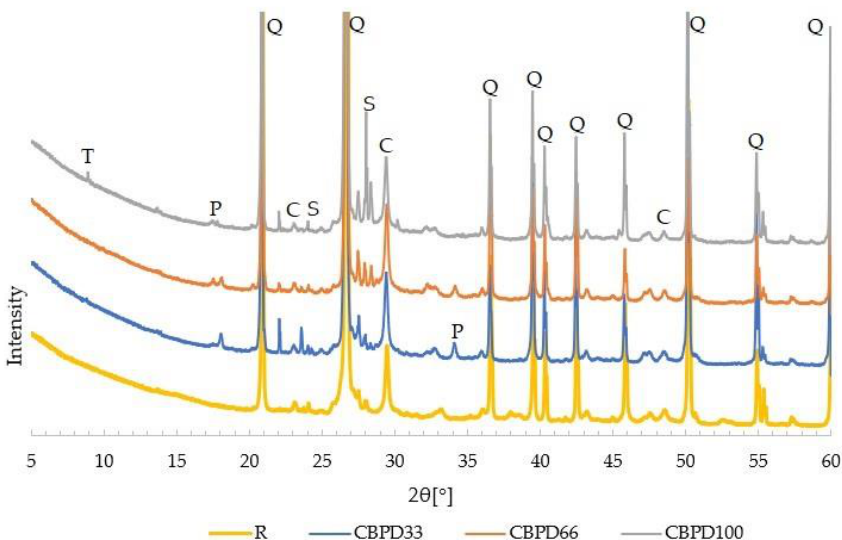
Figure 7. Diffraction pattern of autoclaved sand – lime products with 33%, 66% and 100% CBPD in in relation to free CaO, compared to a reference sample. Designations: C—calcite, P—portlandite, relation to free CaO, compared to a reference sample. Designations: C — calcite, P — portlandite, S — sylvine, T — tobermorite, Q — quartz. S—sylvine, T—tobermorite,